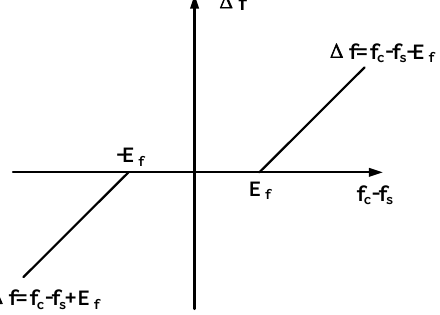
Figure 3. The common frequency dead zone.